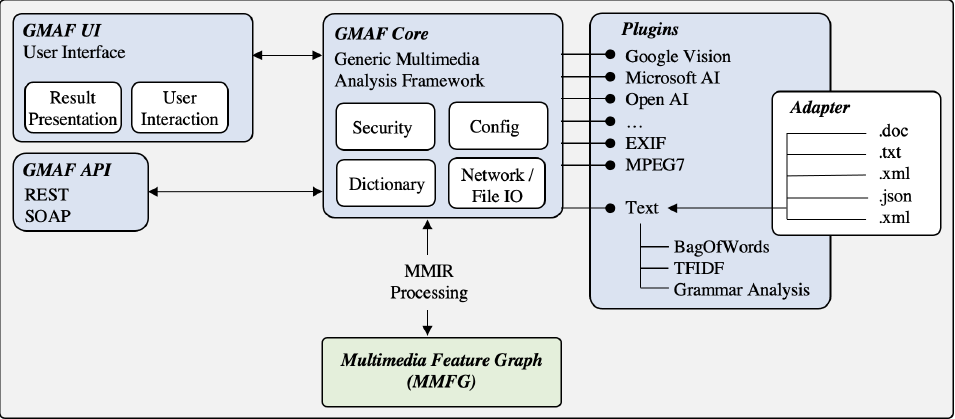
Figure 2. Overview of the generic multimedia analysis framework